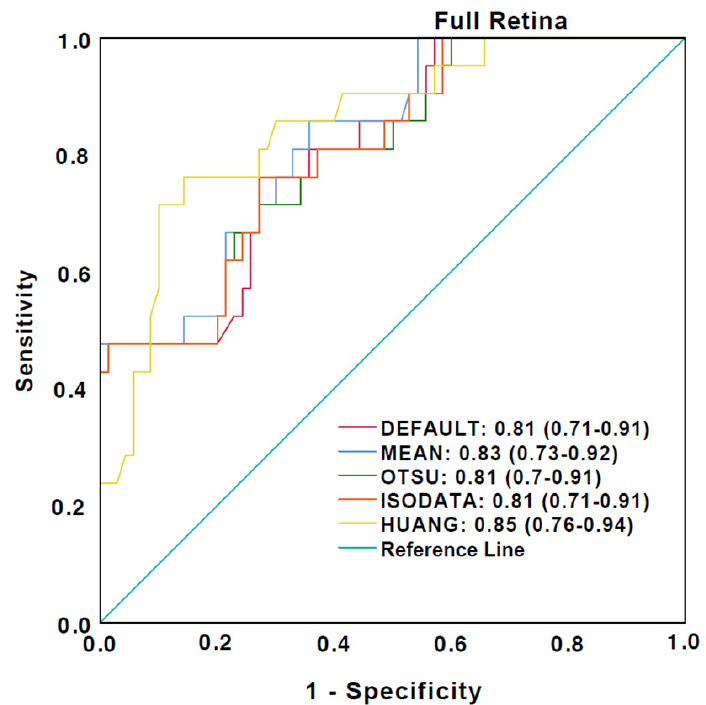
Figure 4. Receiver operating characteristics (ROC) curves for discrimination of diseased eyes from the healthy control group in the full retina slabs. The caption shows the area under the curve (AUC) values and the 95% confidence interval.